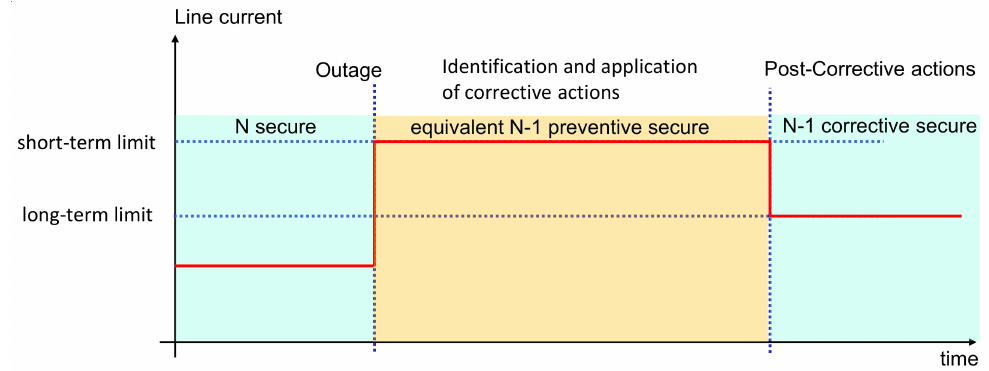
Figure 1. Time domain application of the N-1 security-corrective